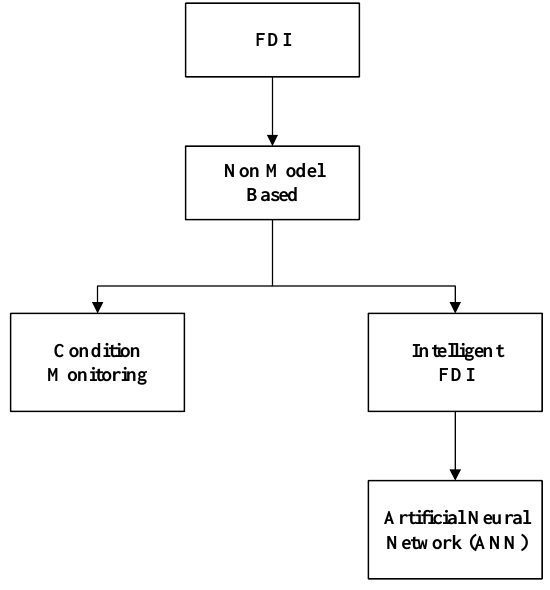
Fig . 2 Fault Detection and Isolation ( FDI